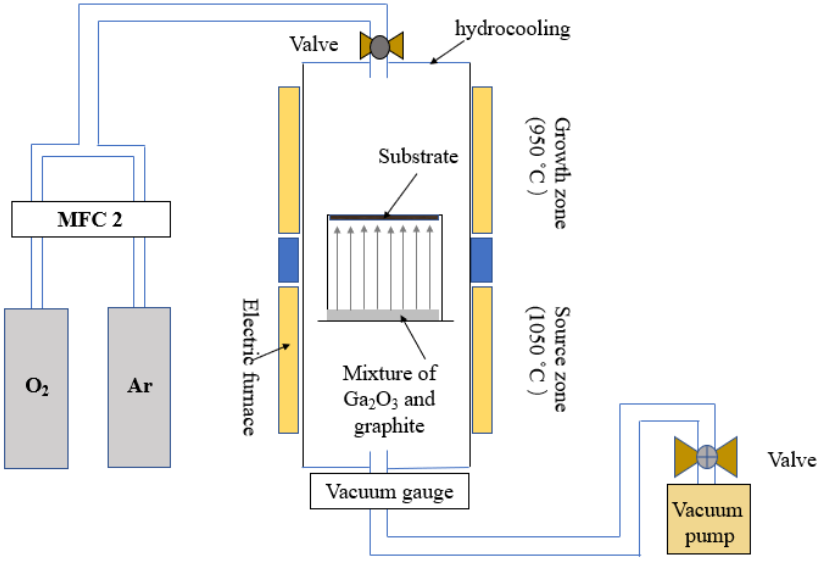
Figure 2. The schematic diagram of the home-made growing system.